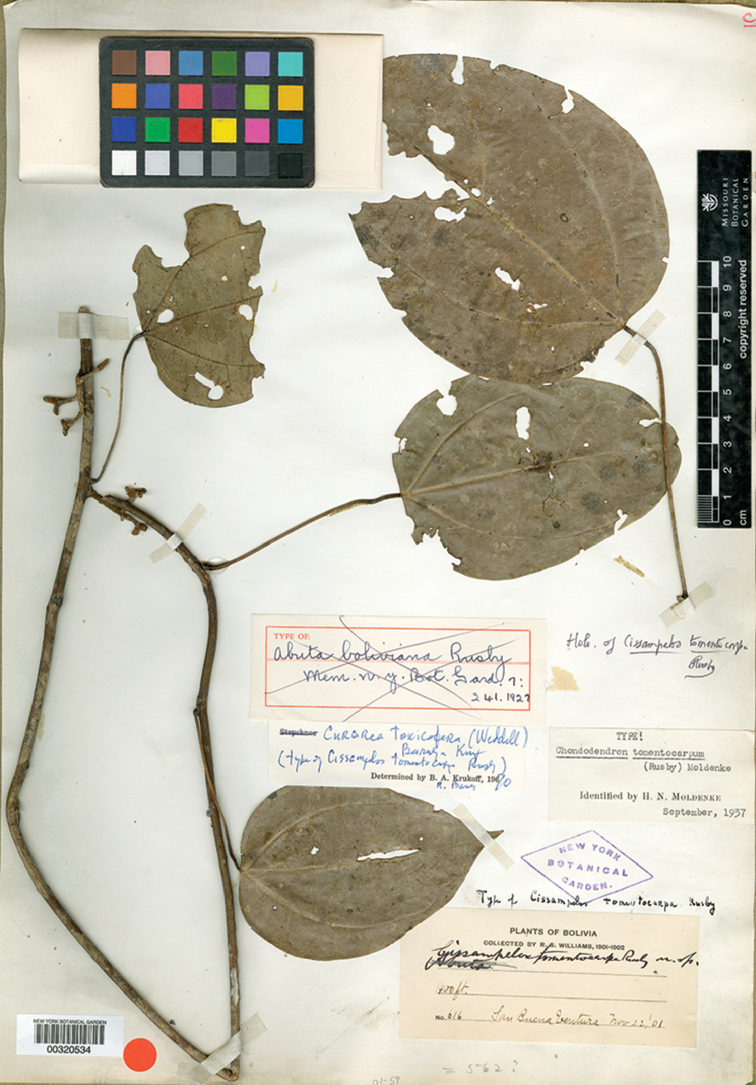

Curarea
tomentocarpa (photograph of the type of Cissampelos
tomentocarpa, Williams 616, NY).